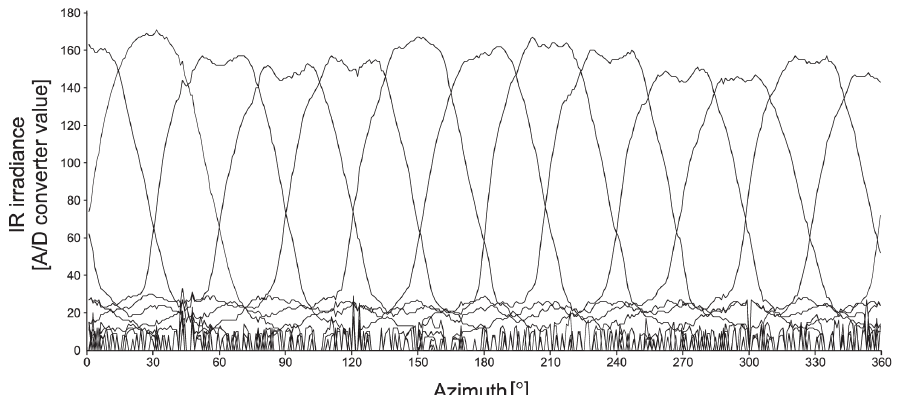
Figure 2. AoA phototransistors’ IR irradiance measurements with varying angle of arrival of the incoming IR signal. Each curve corresponds to one of 12 phototransistors on the AoA sensor. Maximal values for each phototransistor are achieved when the transmitter is positioned near the phototransistor axis, i.e., directly in front of the phototransistor. IR irradiance is measured as a voltage drop on resistors serially connected to phototransistors. The phototransistor collector current and the corresponding voltage drop are proportional to the measured irradiance. The voltage is displayed as a 10-bit A/D converter readout.